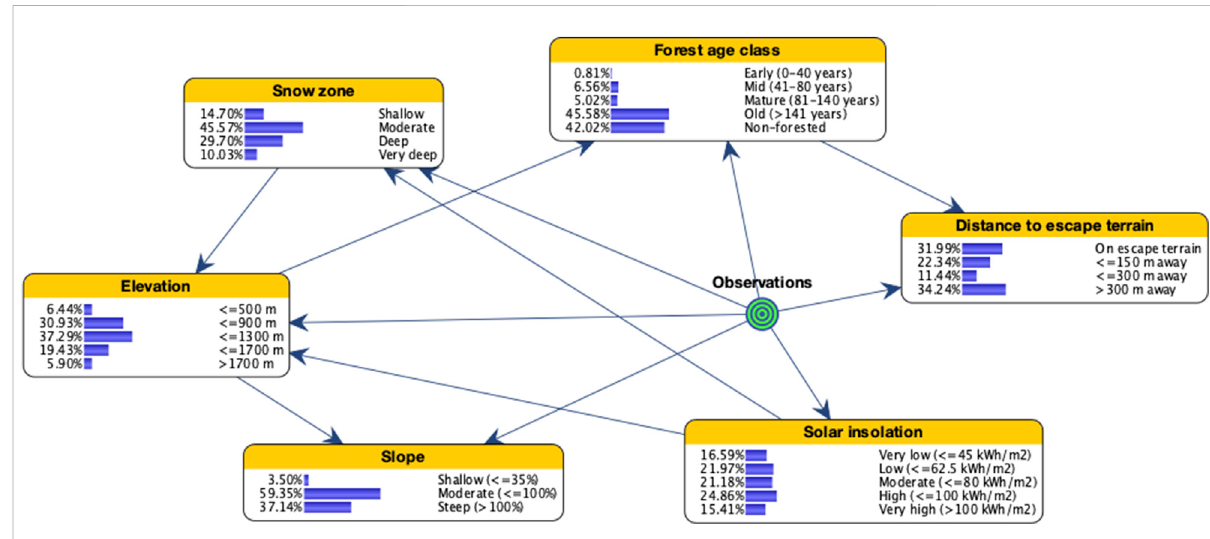
FIGURE 2 Bayesian network model of mountain goat winter range for coastal British Columbia, Canada, illustrating the distribution of states for input variables when setting evidence on